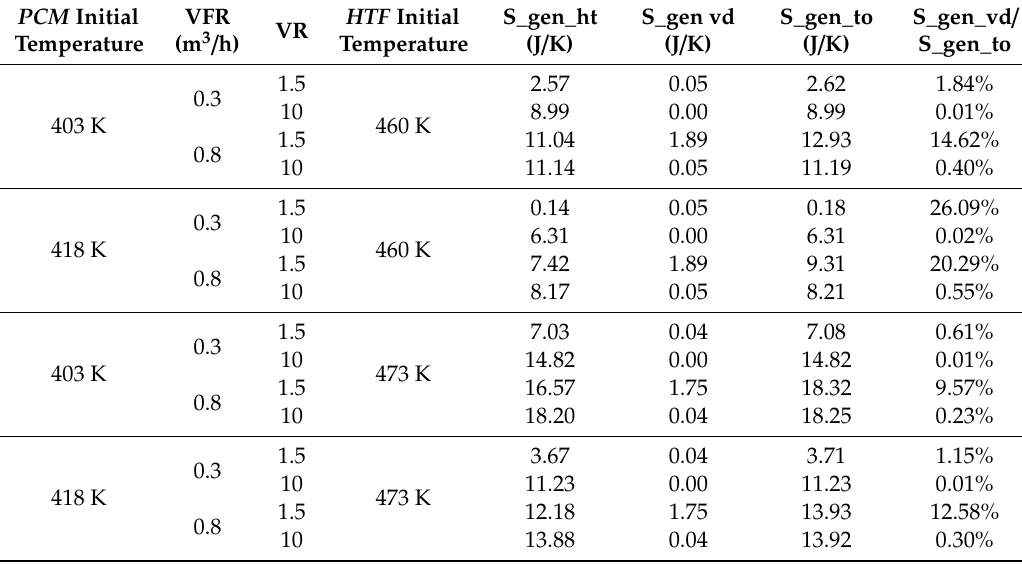
Table 3. Entropy Generation Comparions.